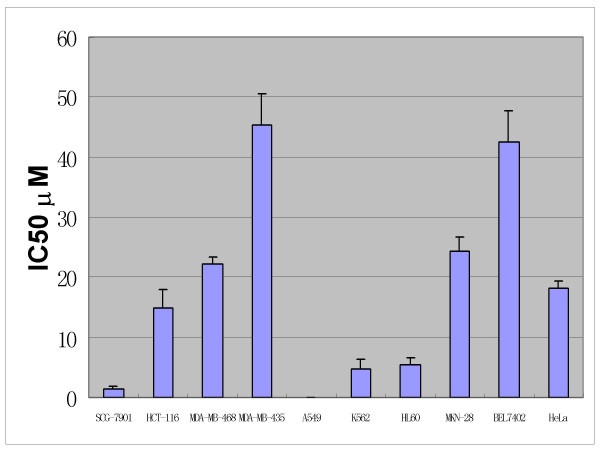
Anticancer activities of probimane in vitro. MTT method is used. Pro exposures for 48 h at 5 different concentrations. n = 3 and in 2 independent tests.